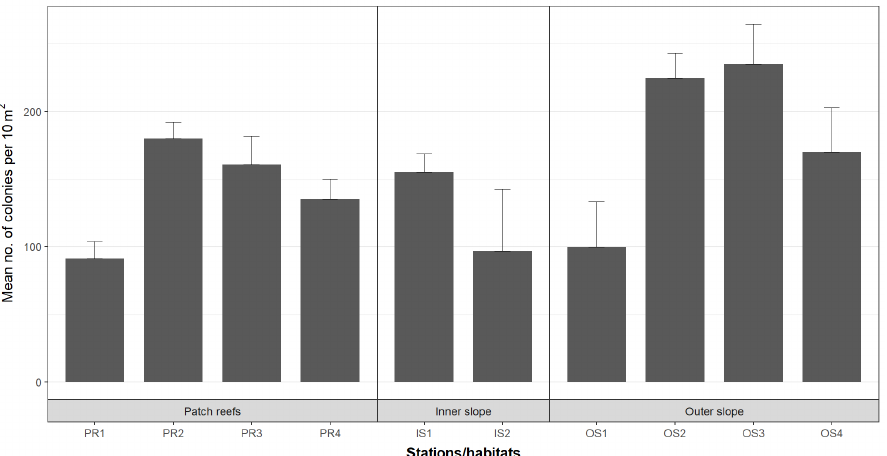
Figure 5. Mean abundance of overall coral colonies (all genera pooled) at the 10 stations located on the three major habitats (PR: patch reefs, IS: inner slope, and OS: outer slope). Error bars represent standard error.